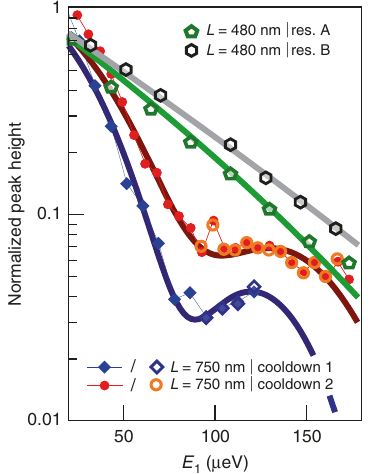
Fig. 4 TLL fi ts with dissipation. Normalized peak height plotted in semi-log scale as a function of injection energy E 1 for L = 480 nm (green pentagons — resonance A, and black hexagons — resonance B) and L = 750 nm (blue diamonds — cooldown 1, and red circles — cooldown 2). The size of the symbols corresponds to our typical experimental accuracy. The open symbols are the Lorentzian fi ts heights, and the full symbols the direct extractions of the amplitude f ( E 1 ) for L = 750 nm. The thick lines are fi ts of the data using the TLL model including dissipation described in the text.